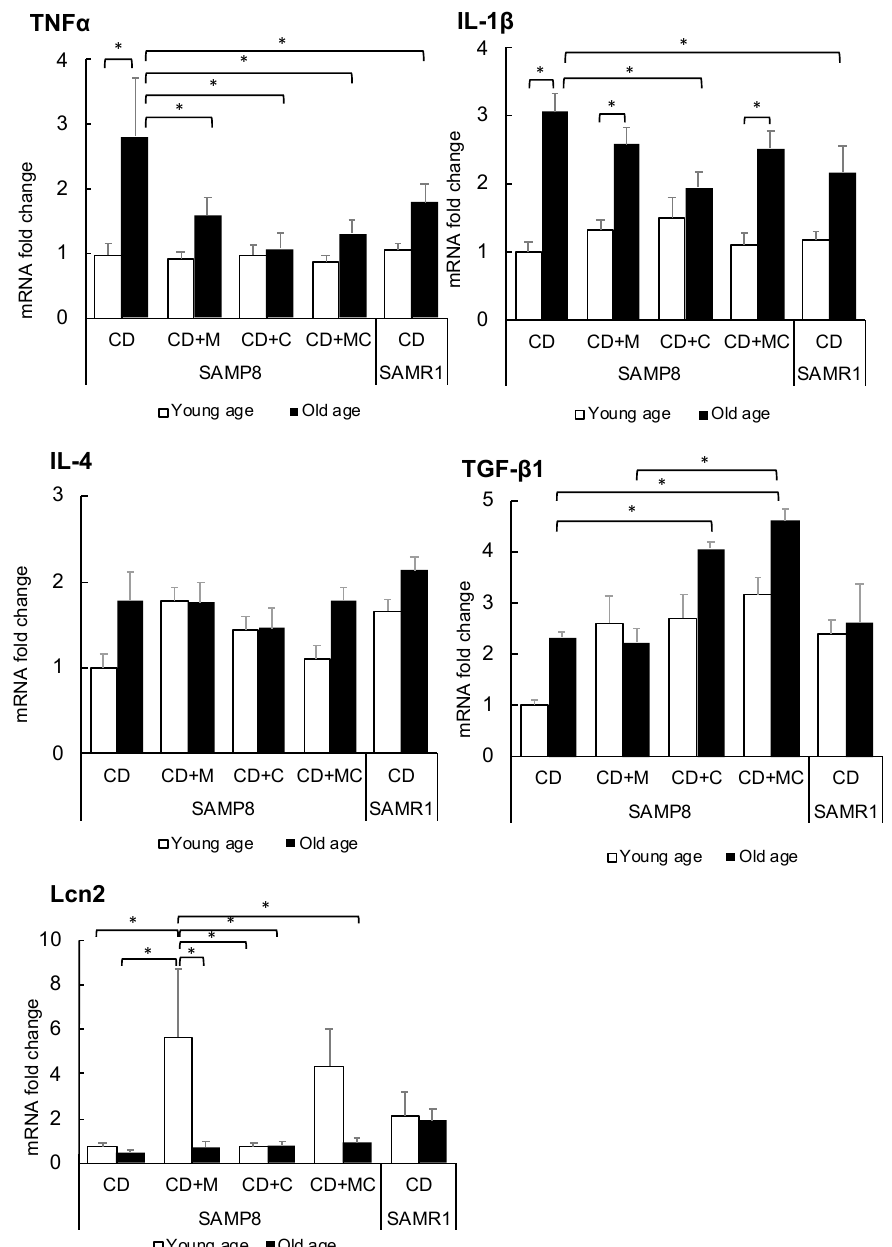
Figure 4. Changes in the expression of inflammatory genes in the hippocampus. Each value represents the mean ± SEM ( n = 6). Asterisks denote significant differences (*, p < 0.05 Fisher’s least significant difference test).